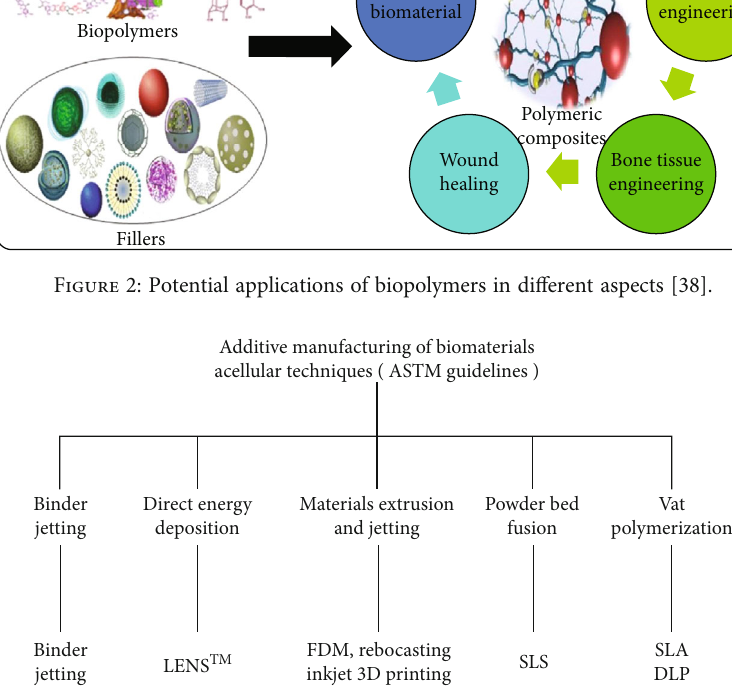
Figure 3: Acellular techniques for biomaterial additive manufacturing